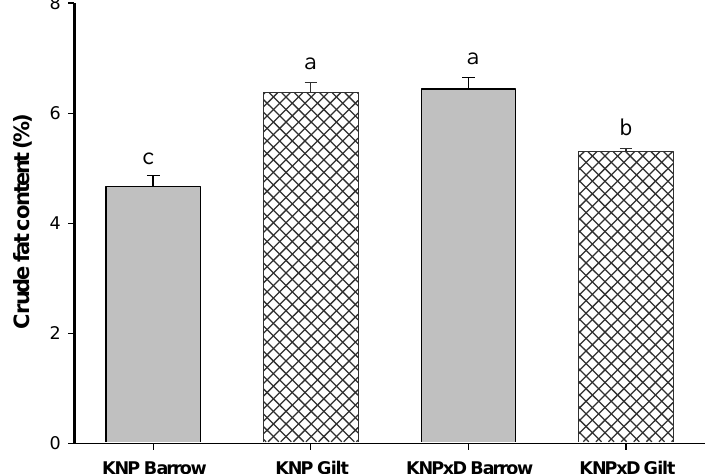
Figure 1. Crude fat content of Musculus longissimus dorsi of Korean Native Black Pigs (KNP) and its crossbred with Duroc